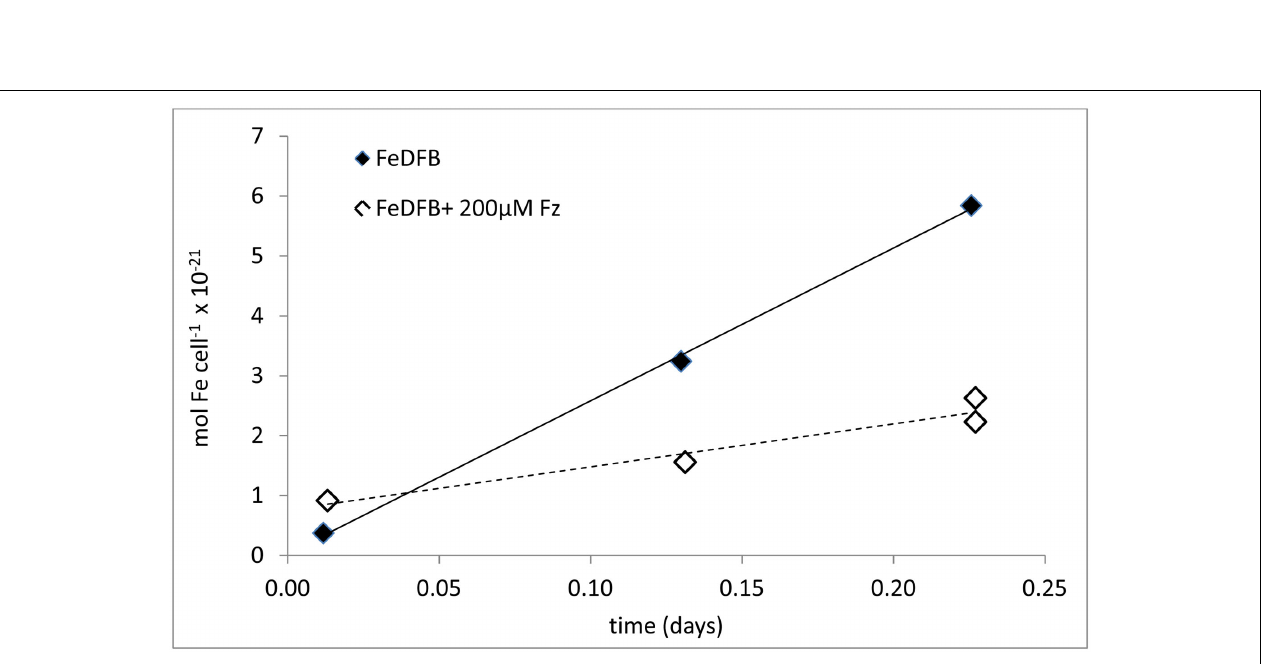
FIGUREA2 | Experimental data of iron uptake by Synechococcus WH8102 in the presence and absence of Ferrozine (Fz), on the basis of which the occurrence of the Fe reductive pathway is deduced. The uptake of iron